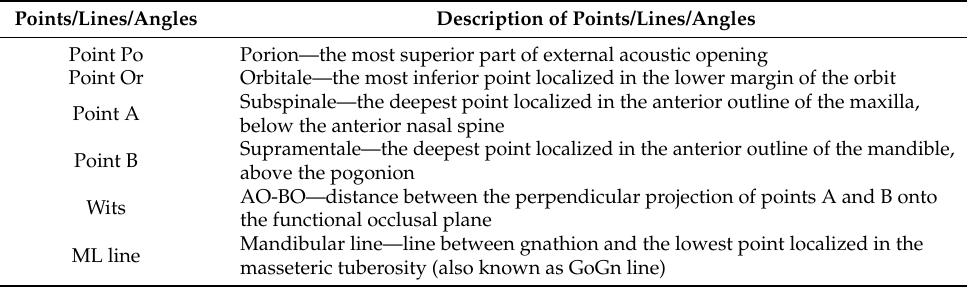
Figure 1. Lateral cephalogram with marked points, lines, and angles presented in Table 2. FMA—Frankfort mandibular plane angle, FMIA—Frankfort mandibular incisor plane angle, IMPA—incisor mandibular plane angle, ML line—mandibular line, FH line—Frankfort horizontal line, L1 line—long axis of lower incisor, Z-line—the profile line. Table 2. List of points, lines, and angles used to analyze the mandibular position and morphology, as well as the position of the lower incisors on the basis of the literature